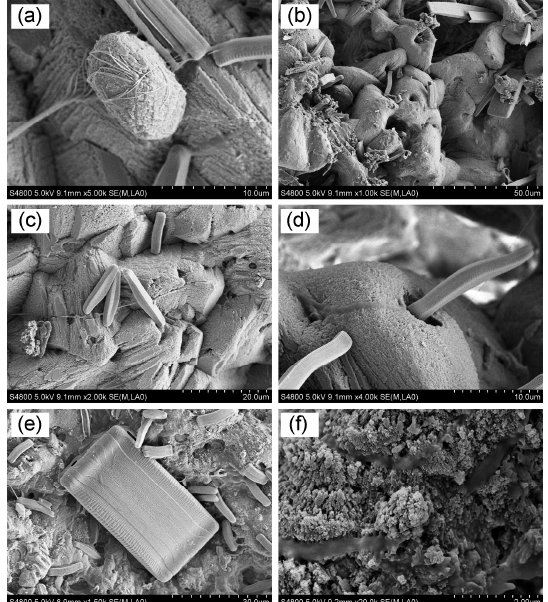
Figure 8. Scanning electron micrographs of secretions produced from diatoms and pores in tufa deposits. ( a ) Diatoms and their thread-like secretions that entwine CaCO 3 particles, S PS 1; ( b , c ) Common occurrence of pores in the center of calcite crystals and pores obstructed partially by decayed diatoms or limestone, S PL ; ( d ) Calcite crystal engulfs part of one diatom stalk and mucilaginous secretions produced from diatoms, S PL ; ( e ) Diatom flora of Fragilaria and their secretions on the tufa surface, S PS 2; ( f ) A higher magnification view shows a rough and loose CaCO 3 exterior and filamentous secretions, S PS 3.